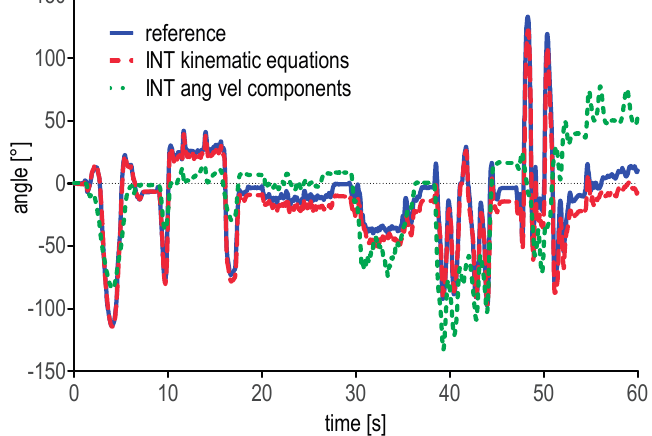
Figure 7. Heading angles as obtained by the stereophotogrammetric system (solid line) and by integration of the kinematic equations (dashed line) are depicted together with the values obtained by integration of the Z component of the angular velocity (dotted line) measured by the MIMU on the forearm, during one randomly selected manual routine